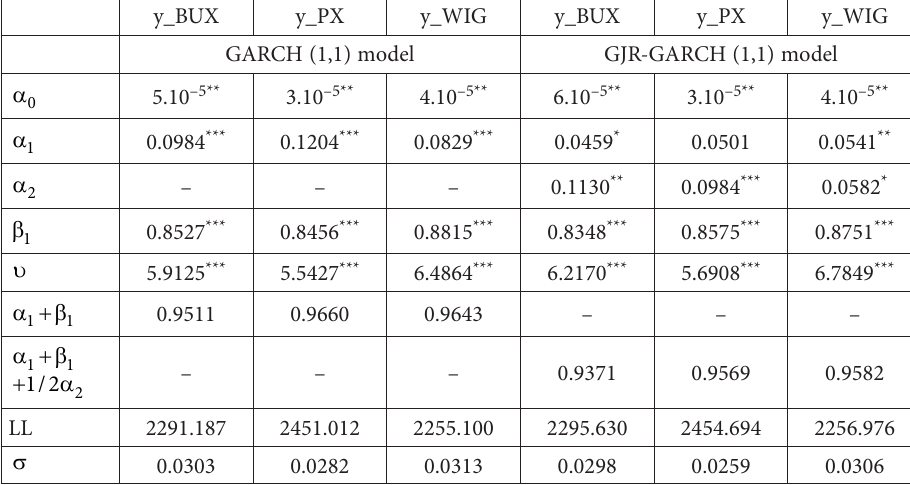
Table 3. Estimation results of GARCH (1,1)/GJR-GARCH (1,1) models with t -distribution (source: own calculations in R, package